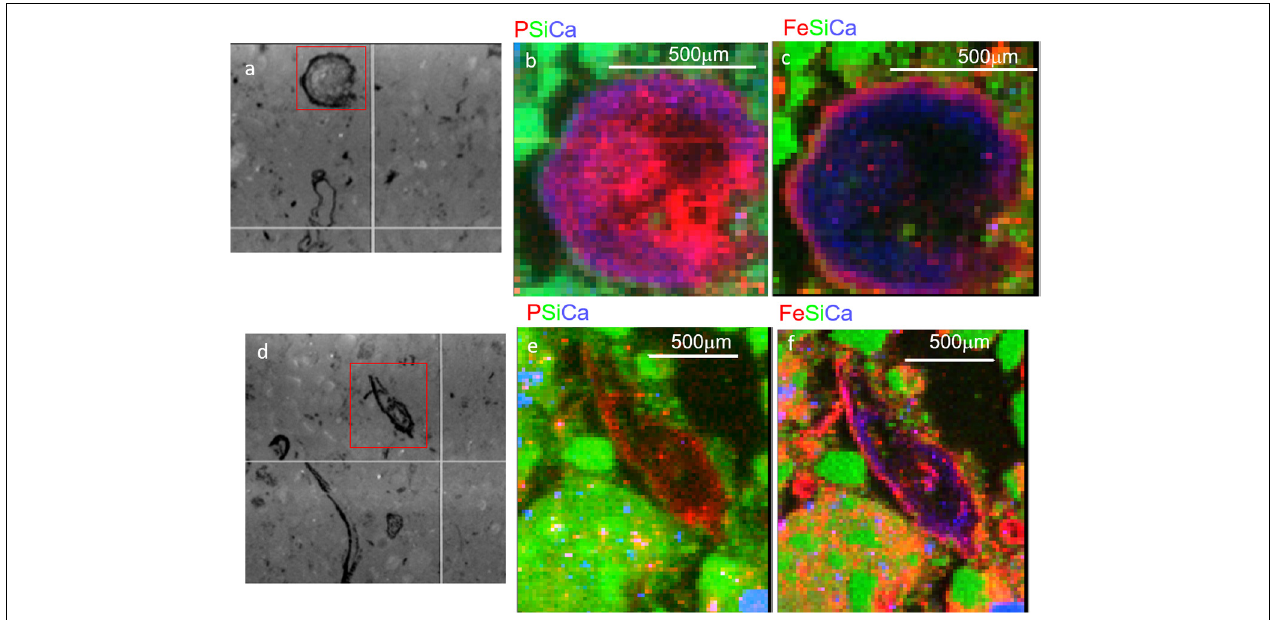
FIGURE 2 | Micro x-ray fluorescence ( µ -XRF) maps of soil from Terrace 3 at 15–21 cm depth. Two regions with organic-rich detritus are shown, with microscope images in panels (a,d) , and tri-color elemental maps (area indicated by red box) for P, Si, and Ca (b,e) and Fe, Si, and Ca (c,f) . Note the smaller red dots scattered throughout (e) are artifacts from the high Si concentrations and do not represent actual